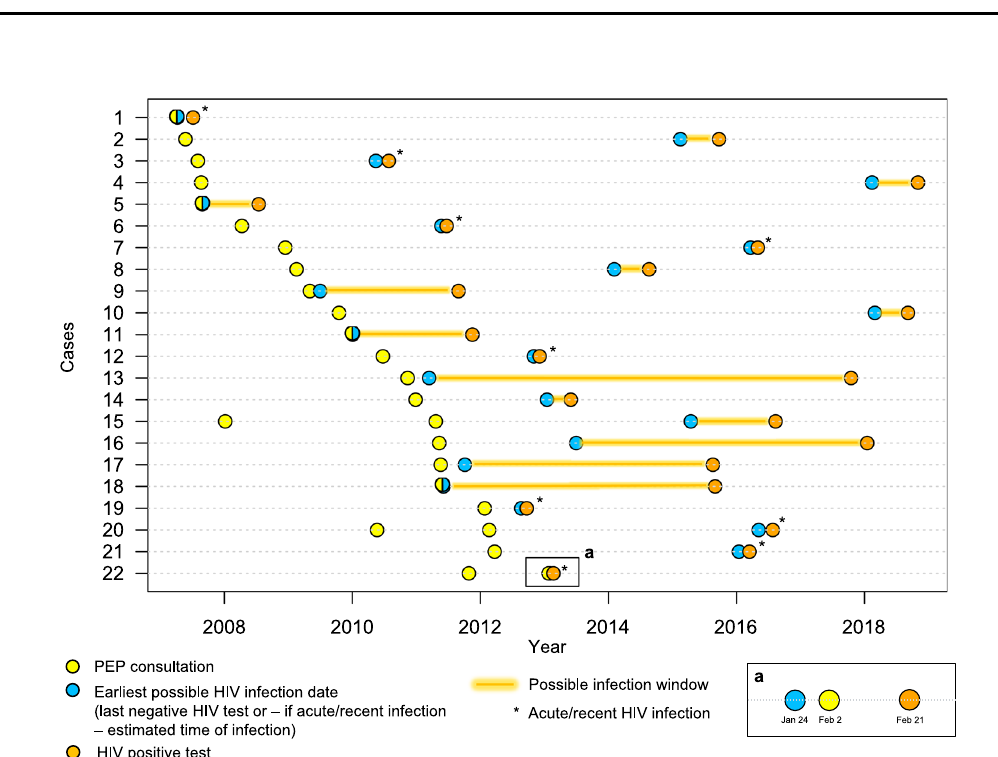
Fig. 2 Clinical trajectories of PEP seekers diagnosed with HIV ( n = 22). Nine individuals presented clinical signs compatible with primary HIV infection (i.e., acute or recent infection). PEP failure was possible in 6 cases: the start of the infection window occurred within 3 months of PEP consultation (cases number 5, 9, 11, 18 and 22), or HIV was diagnosed at 3 months (case number 1). In case number 22, the estimated time of infection and medical history were compatible with transmission 9 days before PEP consultation (part a). PEP: post-exposure